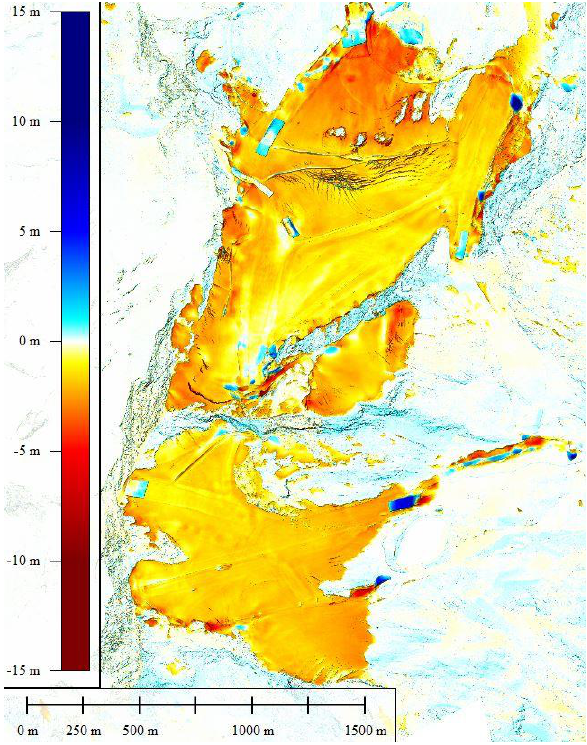
Figure 13. Retreat of the skiing glaciers in Oetztal between 04 Oct. 2014 and 30 Aug. 2015. Rectangular cyan and blue areas close to the glaciers show snow reservoirs covered by protective foil.